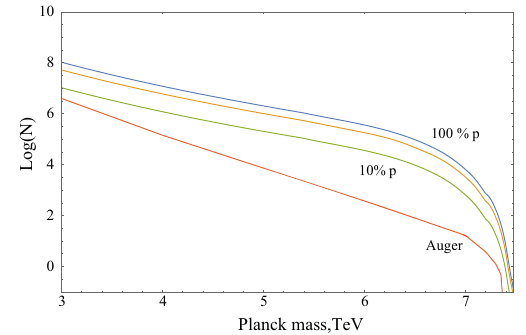
Fig. 5 Theamountoftheneutralblackholes,stoppedbyawhitedwarf with a radius 5600 km during 10 9 year for the different cosmic ray composition: 100% p, 50% p, 10% p fractions and corresponding to Auger data on the mean atomic